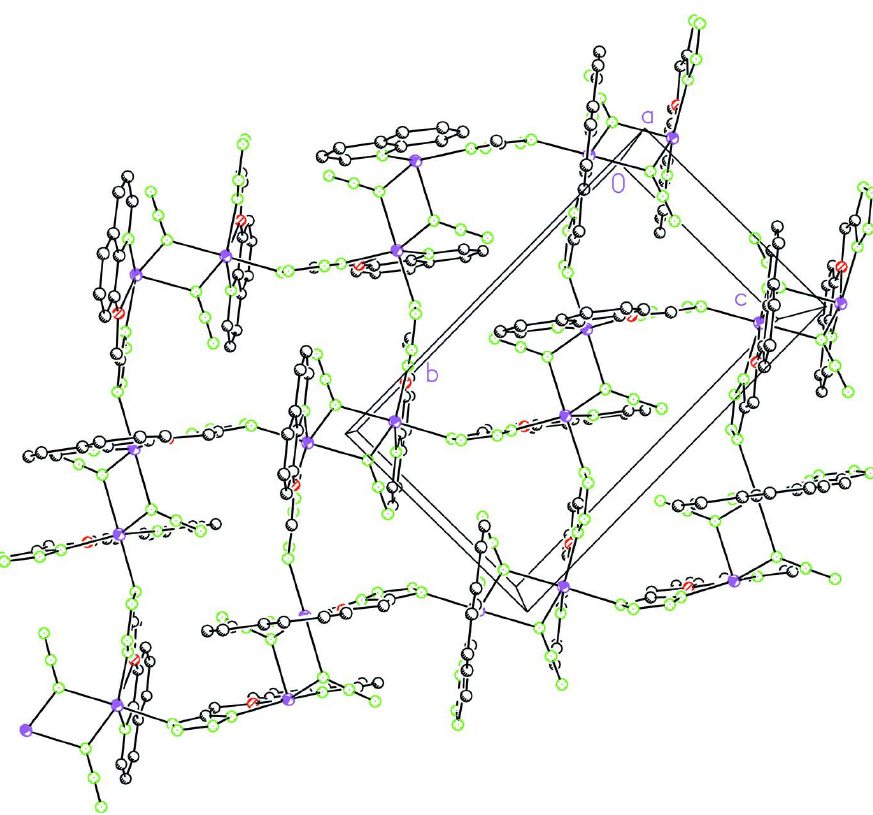
Figure 2 Two–dimensional net framework of the title compound view along a axis and all hydrogen atoms are omitted for